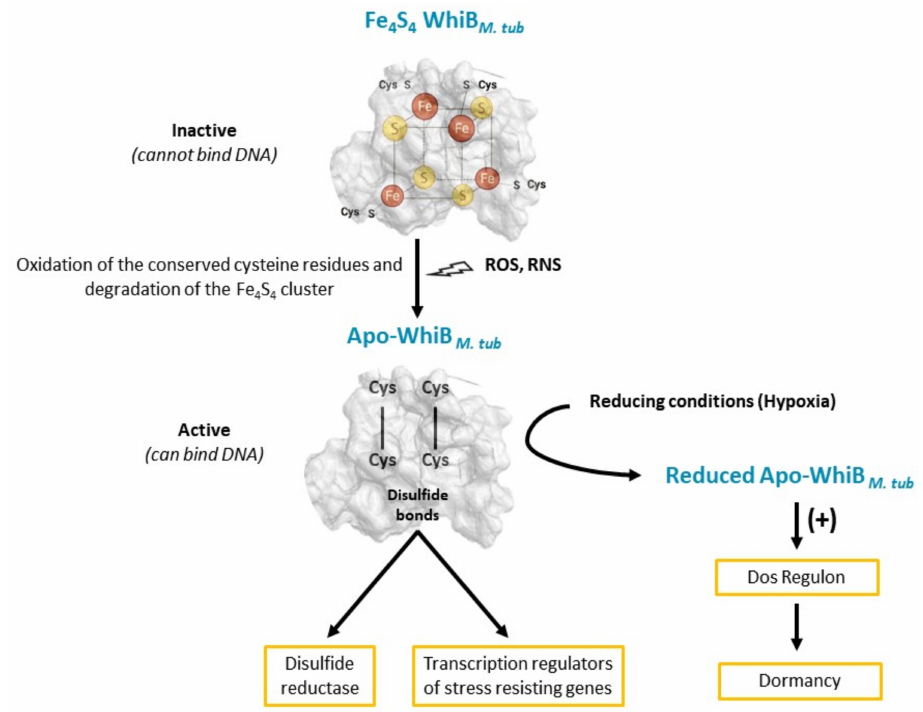
Figure 2. A scheme describing the role of the Fe-S cluster in Mtb WhiB proteins in sensing of extracellular stressors as ROS, NO, and hypoxic conditions. The holo-form of the WhiB containing an intact Fe-S cluster is unable to bind DNA, but when exposed to RNS or ROS, the conserved cysteine residues are oxidized and the Fe-S cluster degraded, leading to the apo-WhiB with disulfide bonds. All apo-forms of WhiB proteins, except WhiB2, display a disulfide reductase activity, and most of the apo-WhiB proteins are transcriptional regulators of stress-resisting genes. Under hypoxic conditions, apo-WhiB protein (WhiB6) becomes reduced, and under this form positively regulates the DOS regulon to prepare Mtb for dormancy